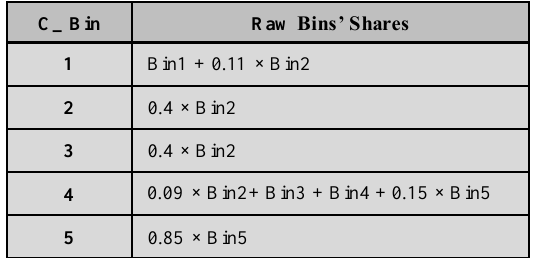
bins and creating the calibration table that defines the percentage share of raw bins in each calibrated one.